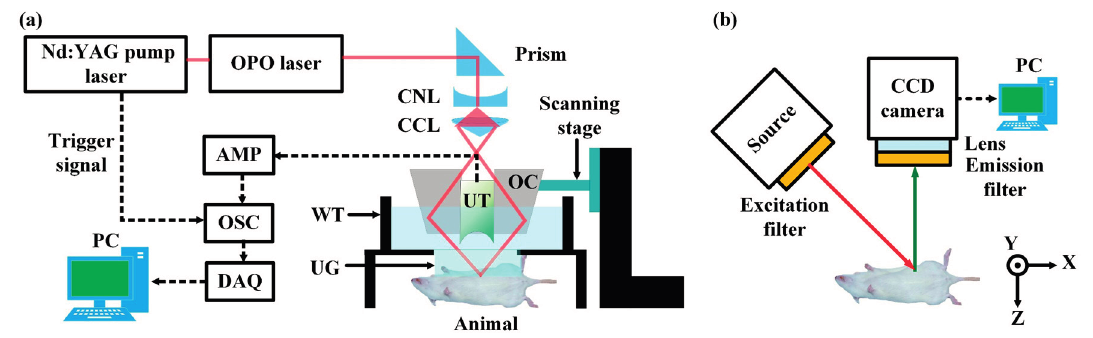
Figure 1. Experimental setups of a dual modal photoacoustic ( a ) and fluorescence ( b ) imaging system . AMP, Amplifier; OSC, oscilloscope; OPO, optical parametric oscillator; CNL, conical lens; CCL, concave lens; OC, optical condenser; UT, ultrasound transducer; WT, water tank; and UG, ultrasound